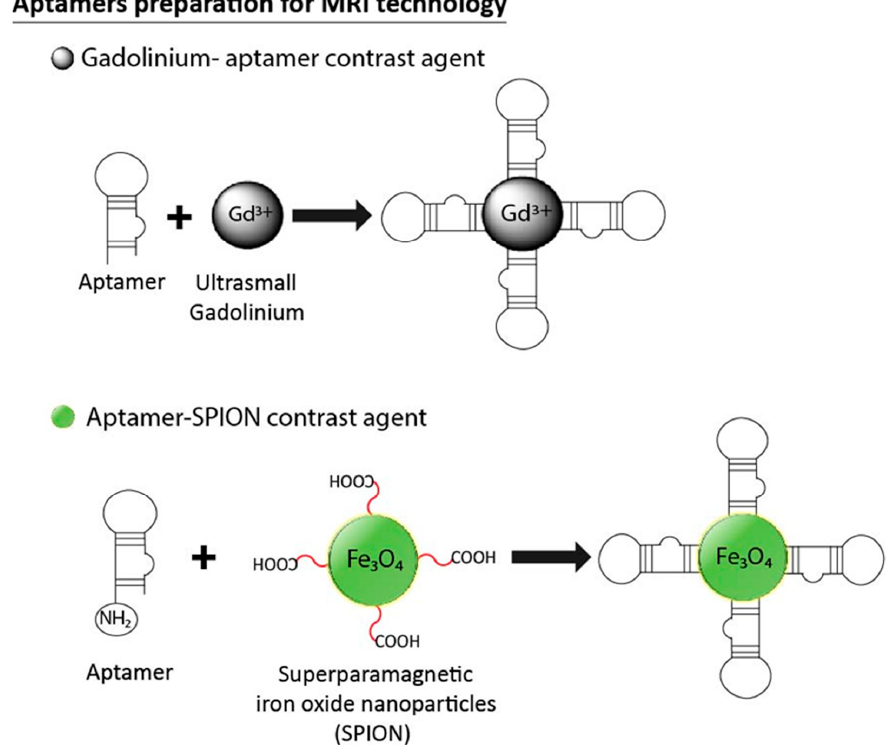
Figure 8. Schematic depiction of aptamer-gadolinium and aptamer-SPION nanoprobes for cancer cell detection with magnetic resonance imaging (MRI) technology. The aptamer can conjugate with gadolinium (Gd(III)) or magnetite (Fe 3 O 4 ) nanoparticles via strong and specific interactions between the aptamer and the nanoparticle. In this sense, the chimeric molecule could be used as a contrast agent because it could change the magnetic relaxation time in a measurable way when targeting the cancer cell.